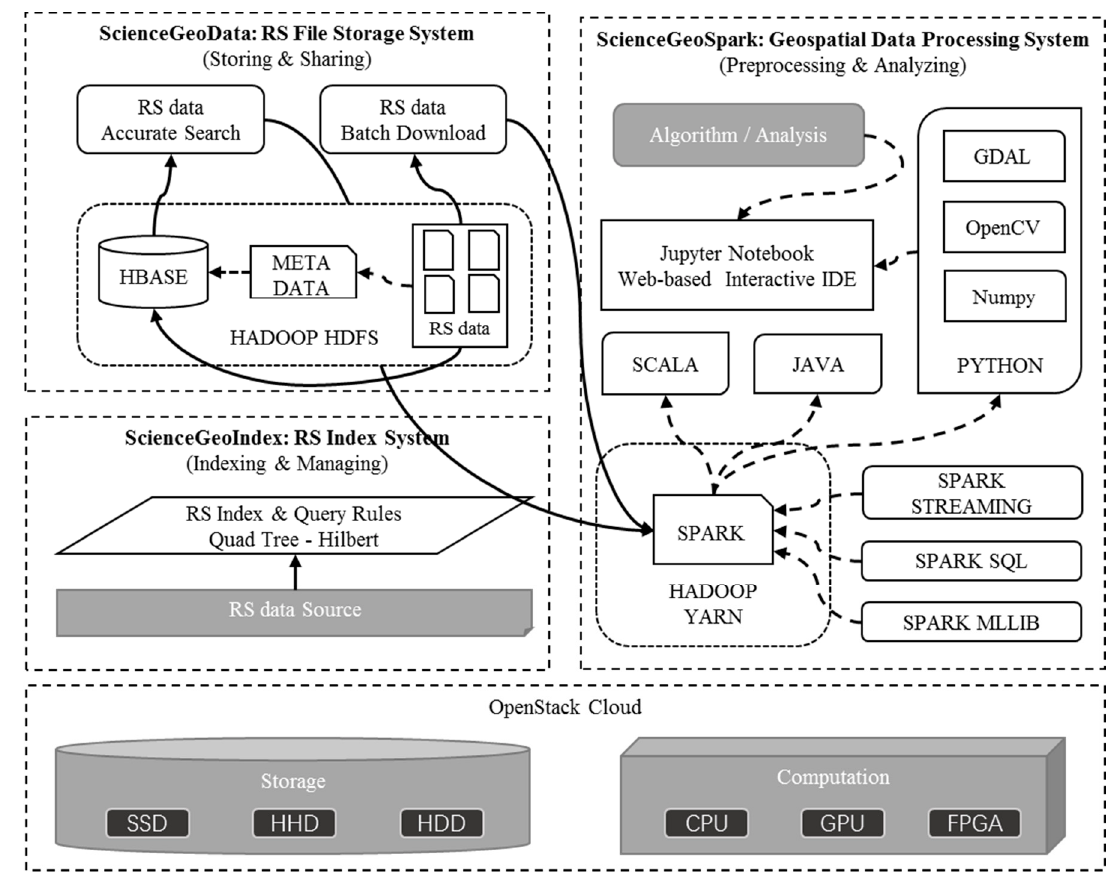
Figure 1. Architecture of ScienceEarth prototype.